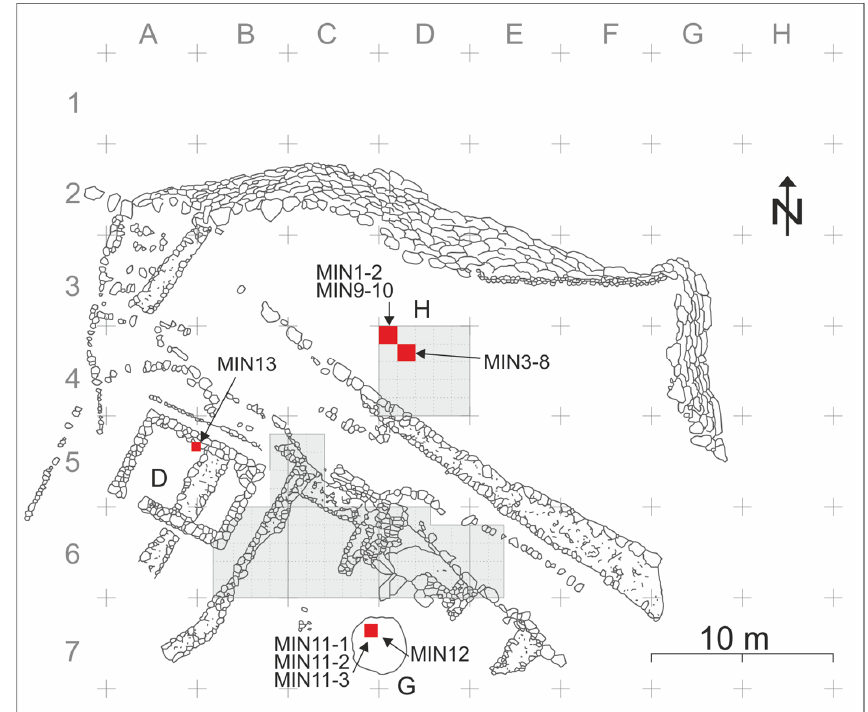
Figure 4. Sketch map of the archaeological site of Cap de Forma, showing the sampling grid and the sampled points (red squares) with the corresponding label (modified after [42]). D = house-fort ; G = water ancient cistern; H = archaeological dug pit.